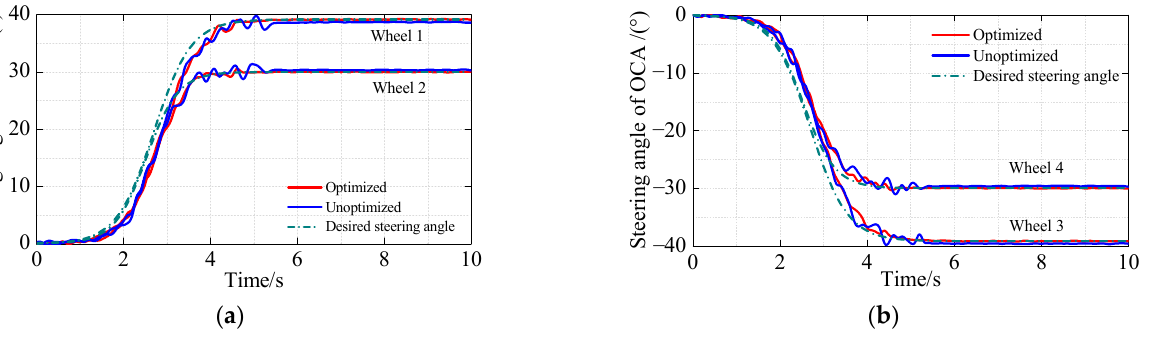
Figure 10. Steering angle curves of four OCAs: ( a ) Angle changes for wheel 1 and 2, ( b ) Angle changes for wheel 3 and